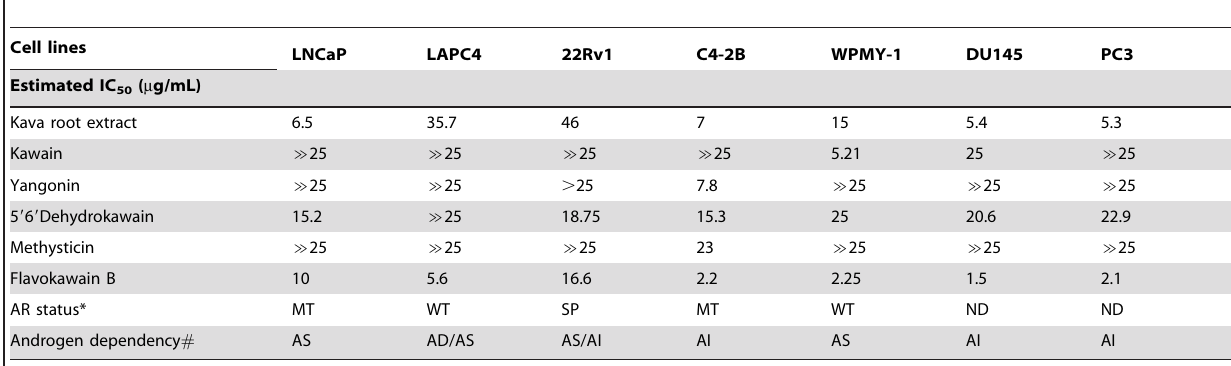
Table 1. The IC 50 s of the kava root extract and its active components and AR status in prostate cell lines.